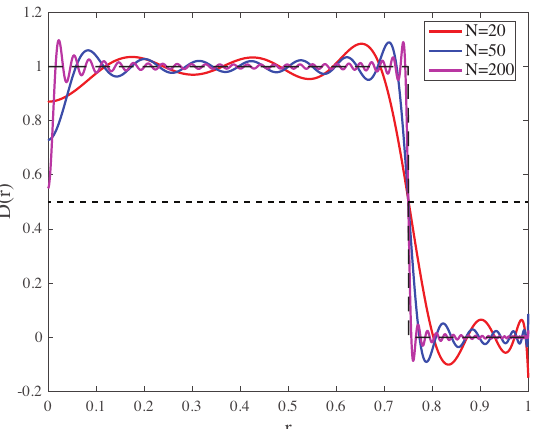
Figure 8. Summation of the series in Equation (33) for n up to N with N = 20,50 and 200 for a scaled sphere with radius of r 0 = 0.75. The series converges to a straight line at value 1 between the origin and r 0 , and vanishes beyond. Note the presence of overshoots, similar to oscillations in truncated Fourier expansions. Those overshoots concentrate as N